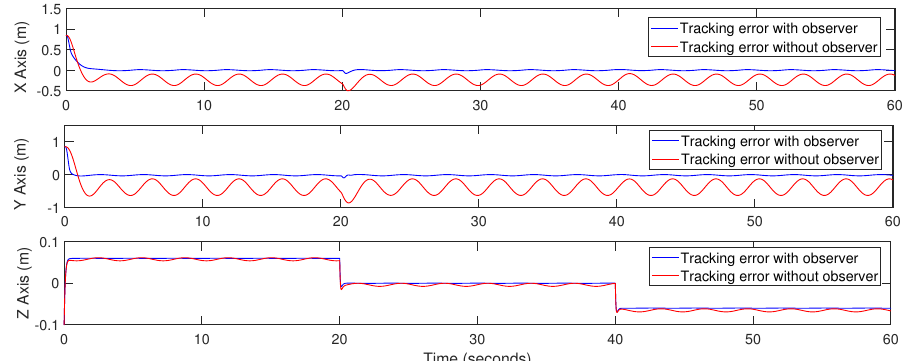
Figure 17. Position tracking Error when [1 + sin ( 2 t ) 1 + sin ( 2 t ) 1 + sin ( 2 t ) ] is applied to the atti- tude subsystem.